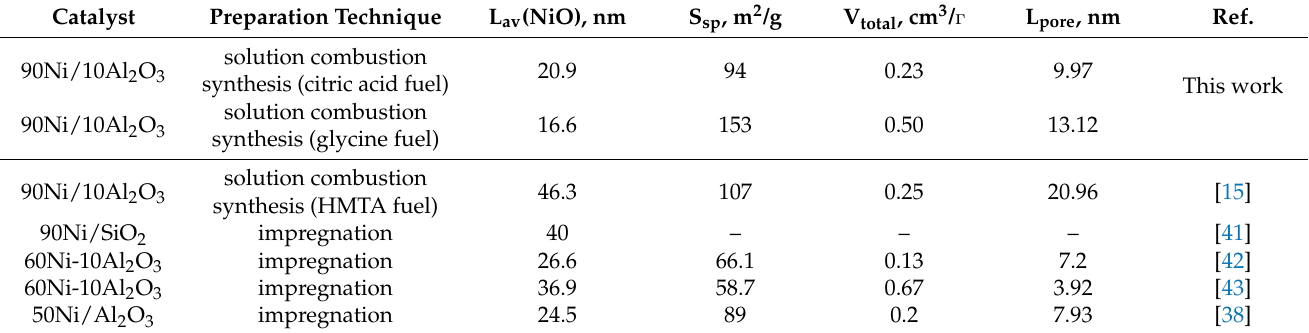
Table 3. A comparison of data on texture properties of catalysts synthesized using various methods.